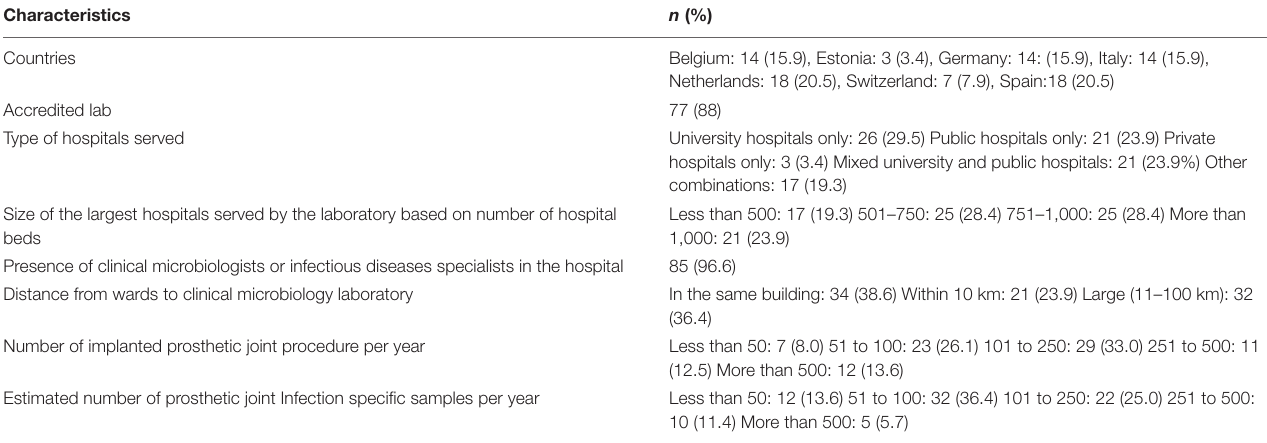
TABLE 1 | Characteristics of clinical microbiologists and the laboratories participated in this survey. Characteristics